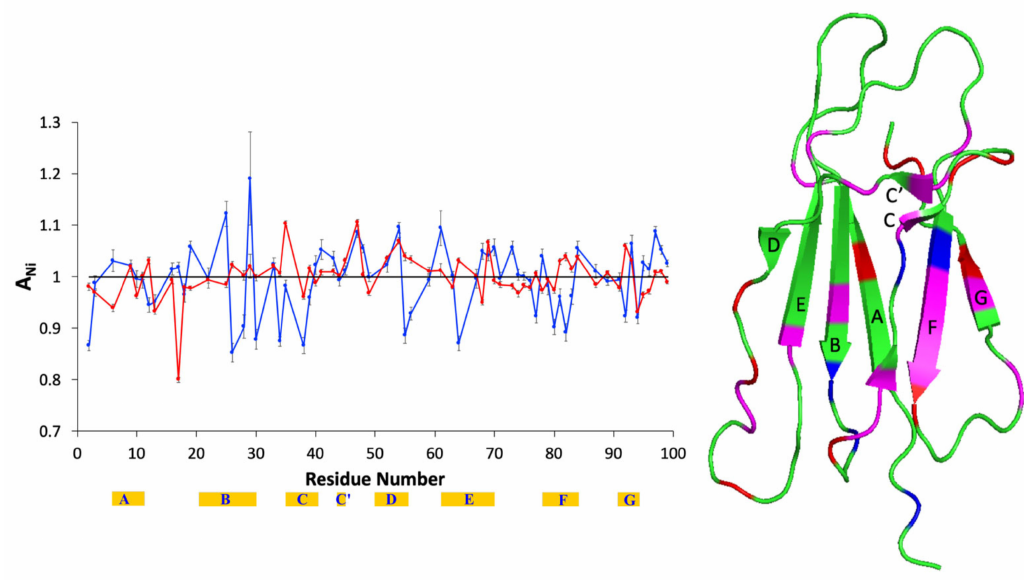
Figure 1. Overlay of the A N values obtained from 1 H- 15 N HSQC spectra of 8 µ M β 2m in the presence of 0.8 mM Tempol, with a relaxation delay of 0.5 s ( blue ) or 5 s ( red ). The β -strand location and naming along the sequence is reported with yellow strips. The cartoon on the right highlights the positions of the accessible amides (red), i.e., exhibiting A N [eq] > 1, and the amides with Type II deviation of A N [o ff -eq] ( blue ), i.e., displaying A N [o ff -eq] < A N [eq]. The magenta color denotes sites where both A N [eq] > 1 and Type II deviation occur simultaneously. Here and elsewhere, the reproduced structure is the NMR solution structure of β 2m [10] (Protein Data Bank or PDB code 1JNJ). The secondary structure elements of β 2m are indicated according to the crystallographic naming scheme (PDB code 3HLA). Structures are always drawn with PyMOL (Schrödinger, Inc., version 2.3.5, New York, NY,